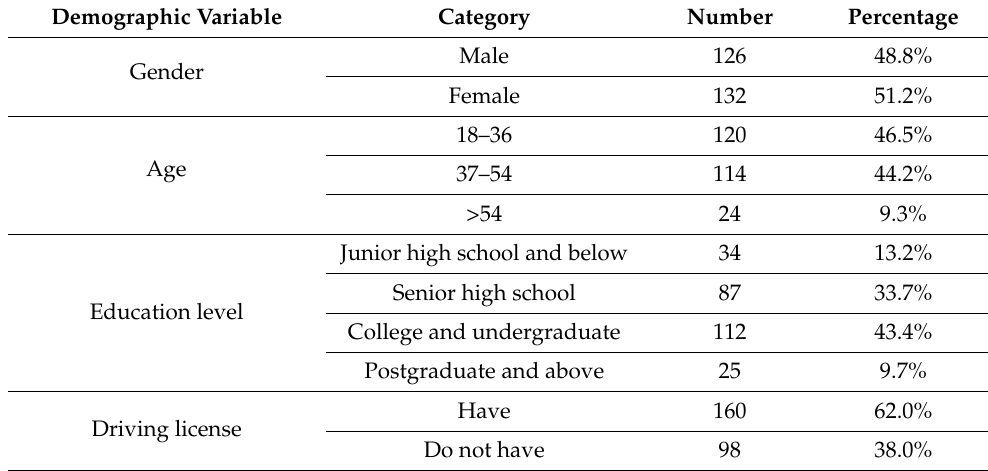
Table 3. Demographic information of the public.